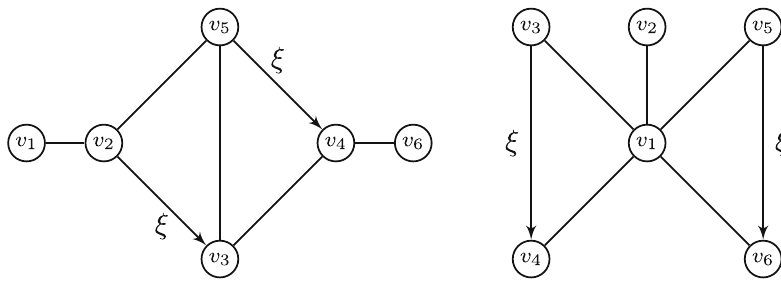
Figure 3: The 5 (cid:3) - gain graphs ψ Γ , 1